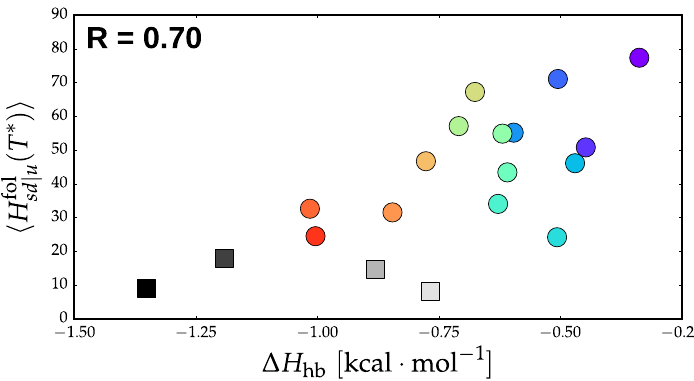
Figure 5. Average conditional path entropy in the folding direction versus the enthalpy of helix extension, ∆ H hb (determined as the slope of ln w ( 1/ T )